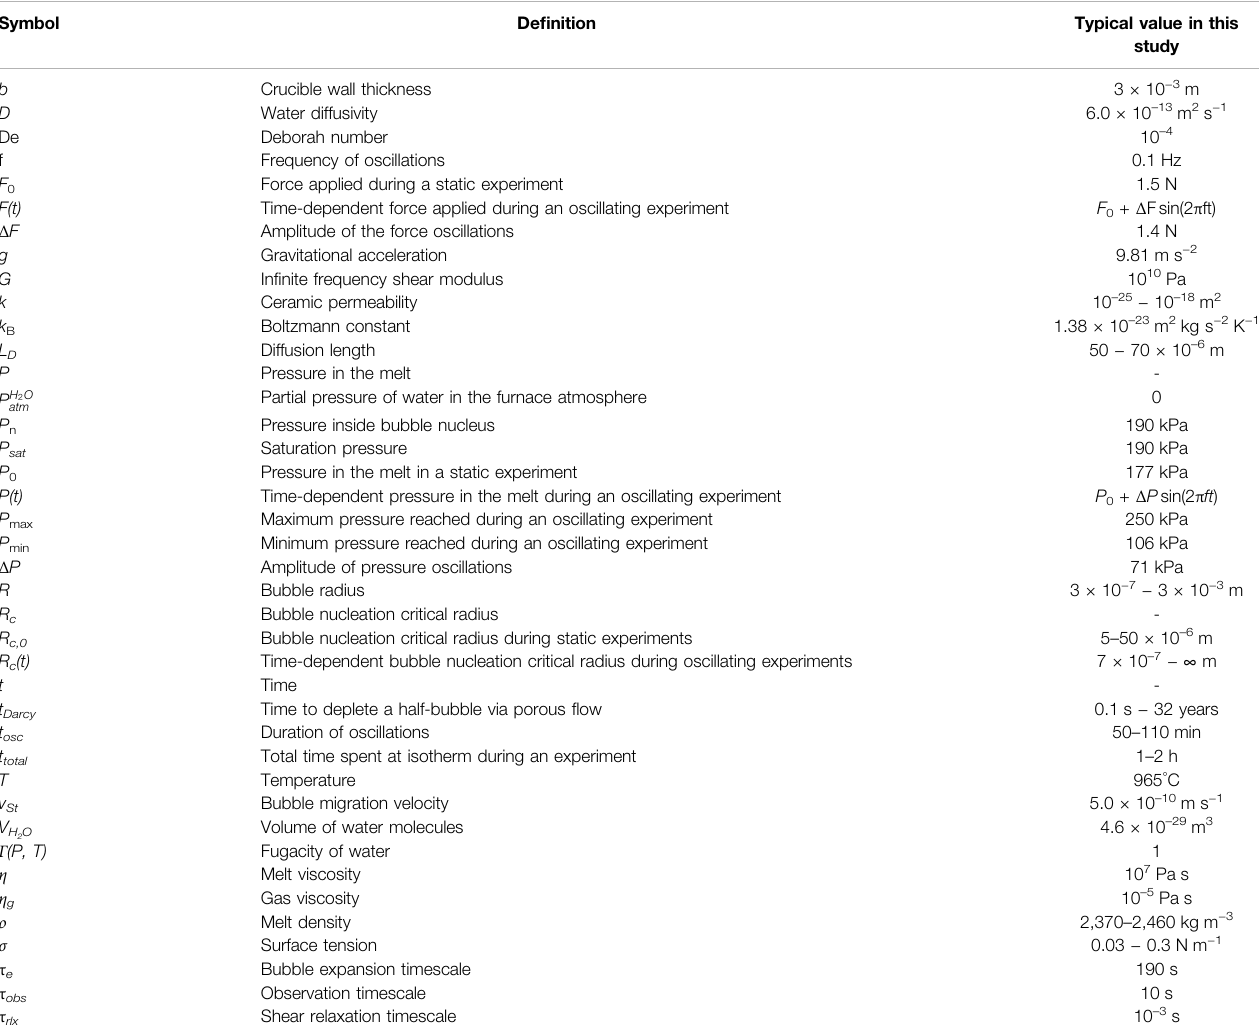
TABLE 2 | List of symbols used in the text and equations.